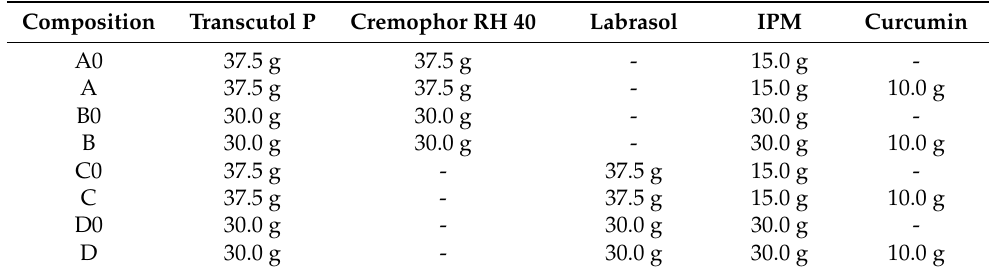
Table 3. The compositions of the formulated self-nanoemulsifying